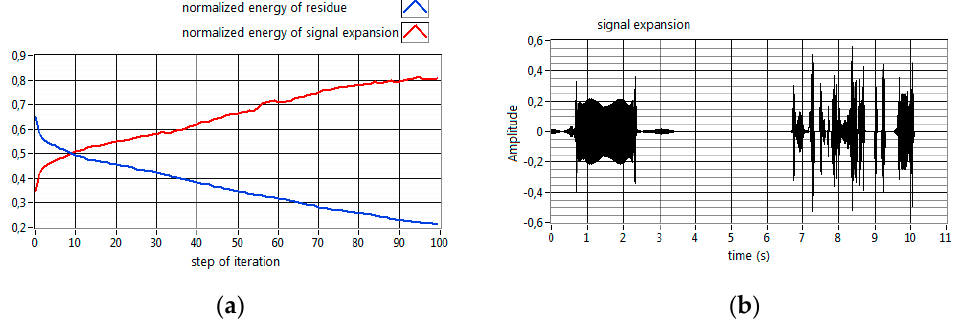
Figure 5. The plots: ( a ) the normalized energy of the residue and the normalized energy of the signal expansion as a function of the iteration steps in the MP algorithm; ( b ) the reconstructed measured signal for dictionary size equal to 100.